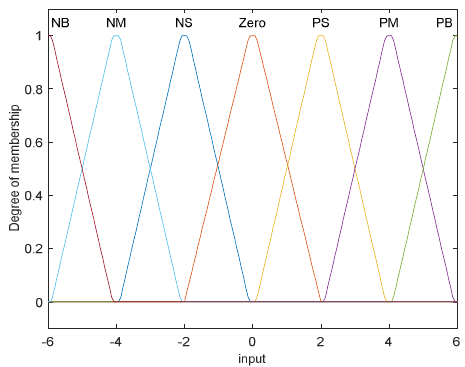
Fig. 4. The membership function of the input variables.